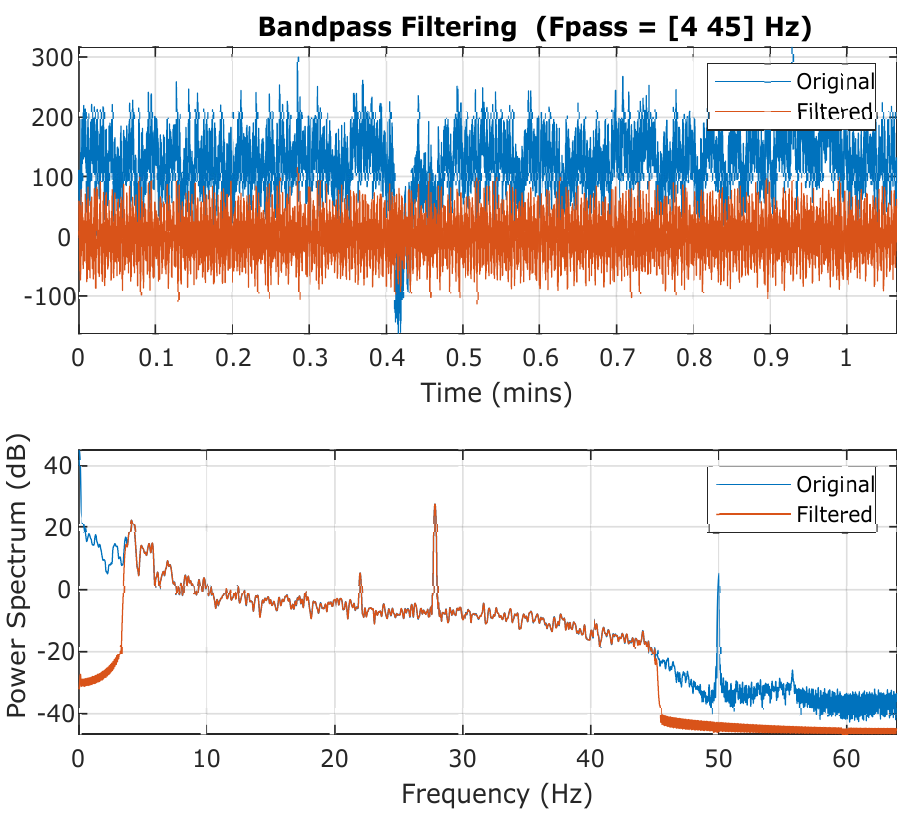
Figure 4. Band-pass filtering 4–45 Hz of individual EEG channel with power